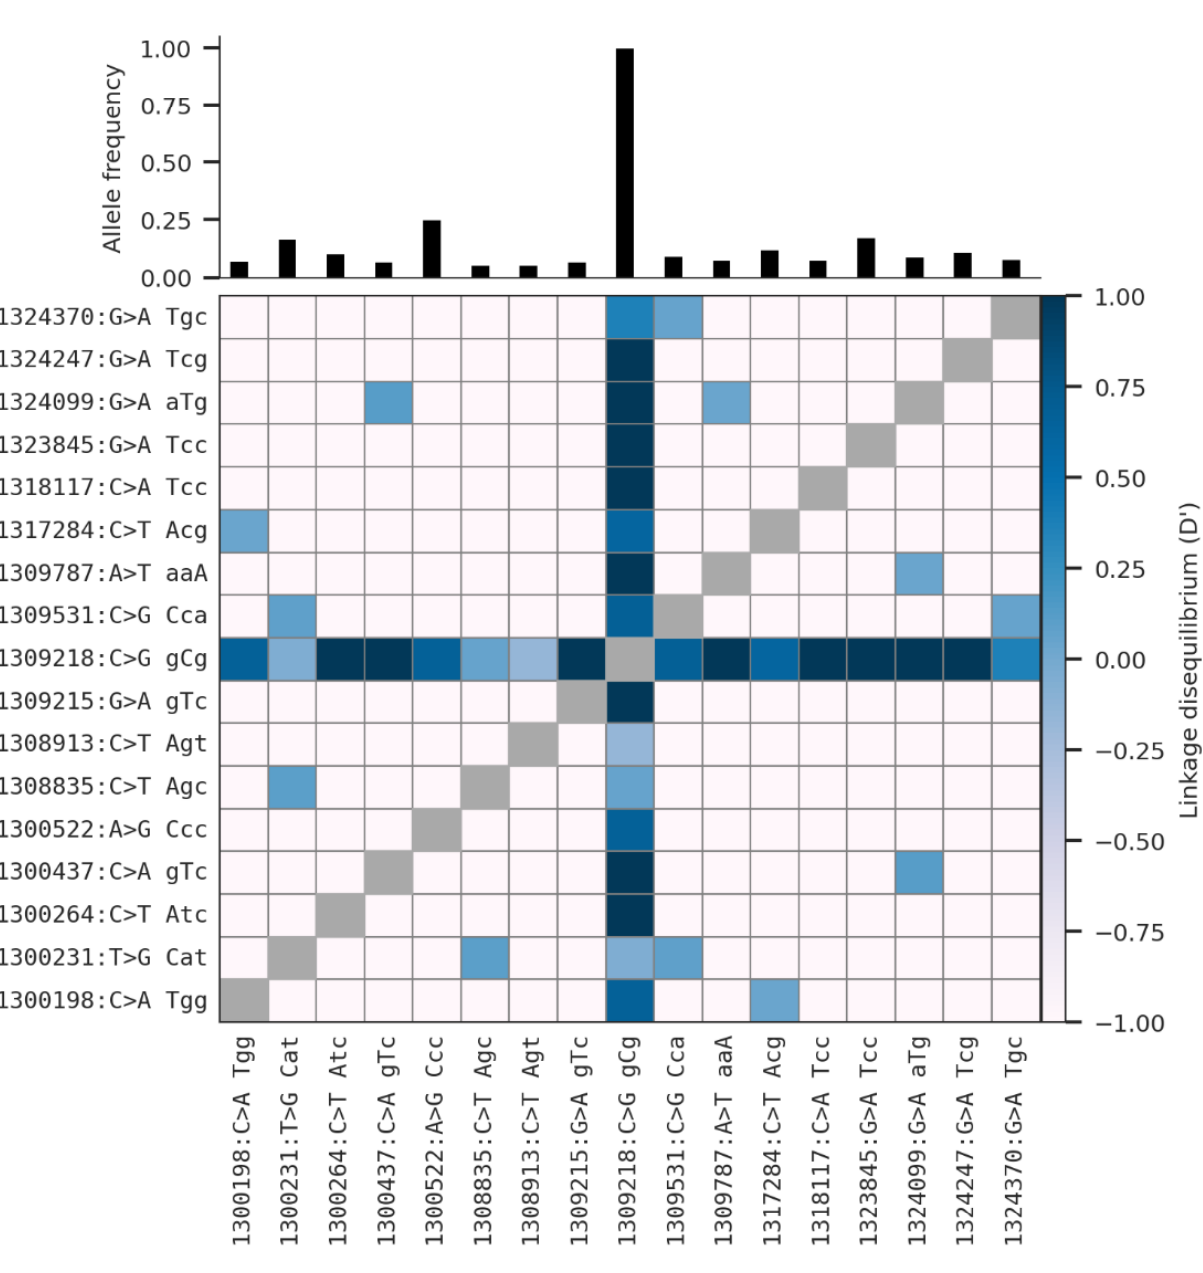
Figure 3. Linkage disequilibrium between the non-synonymous SNPs with maximum allelic frequen- cies that are greater than 5% in at least one population; upper figure shows allelic frequencies; lower figure shows linkage disequilibrium value ( − 1 indicates no LD, and +1 indicates perfect